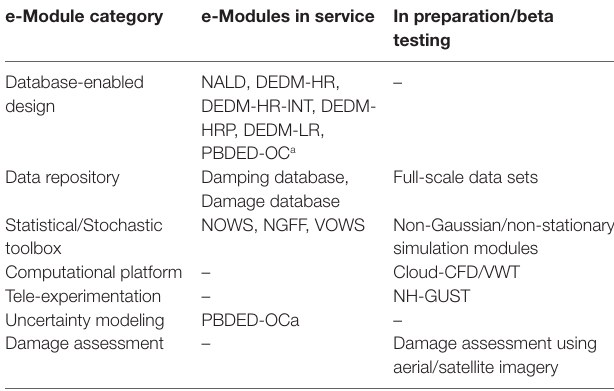
TaBle 1 | Current and ongoing statuses of e-modules in the